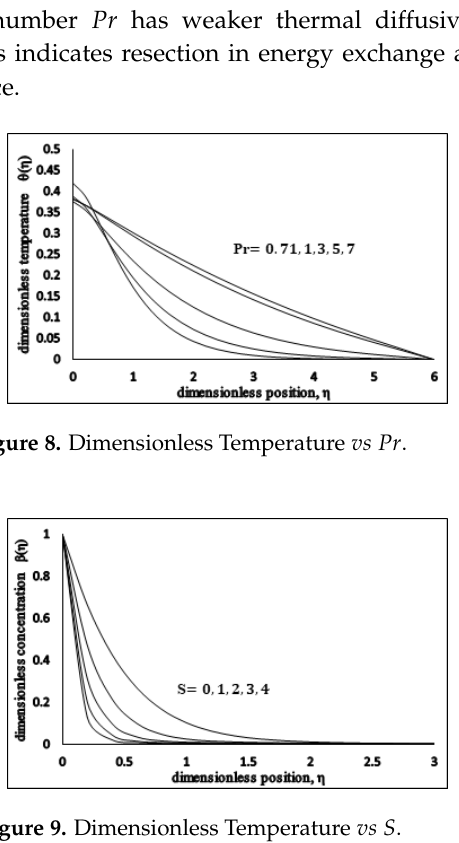
Figure 9. Dimensionless Temperature vs S .